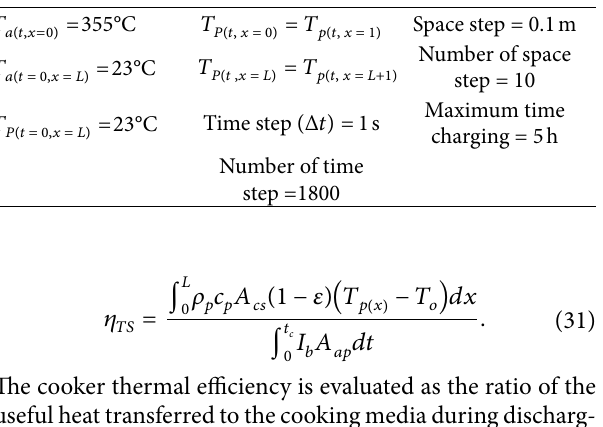
Table 3: Initial and boundary